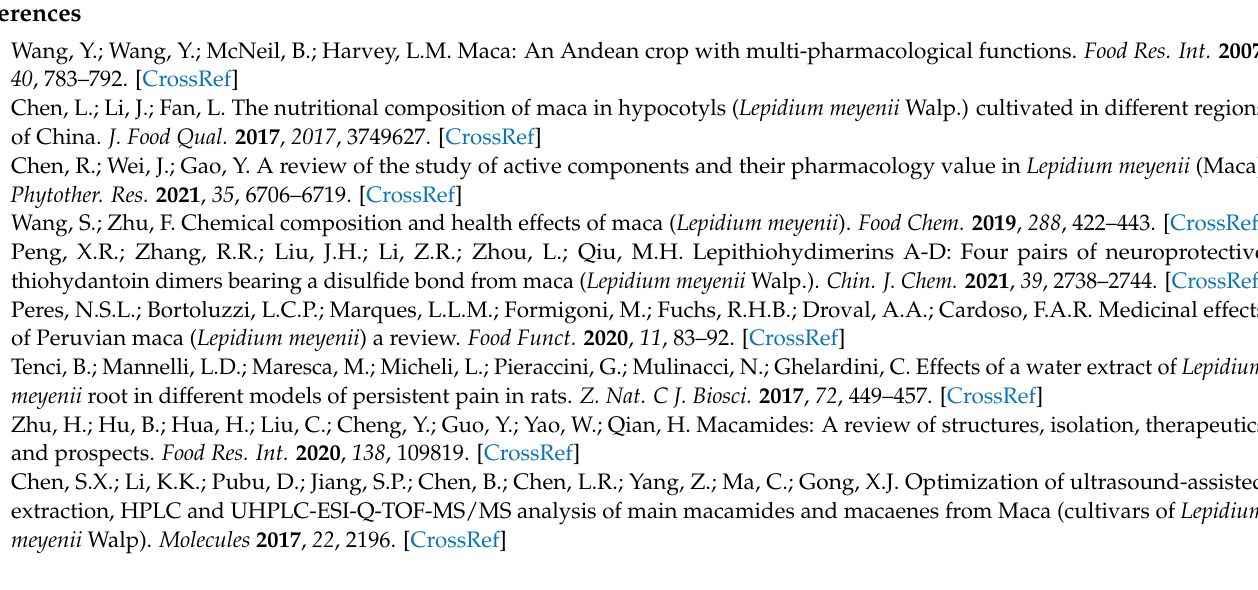
Figure S2: Effect of ultrasound power on the yields of the five target macamides ( 1 Extraction yields of C2, C4 and C5; 2 Extraction yields of C1 and C3); Figure S3: Effect of ratio of solution to solid on the yields of the five target macamides ( 1 Extraction yields of C2, C4 and C5; 2 Extraction yields of C1 and C3); Figure S4: Effect of extraction time on the yields of the five target macamides ( 1 Extraction yields of C2, C4 and C5; 2 Extraction yields of C1 and C3); Figure S5: Effect of extraction temperature on the yields of the five target macamides ( 1 Extraction yields of C2, C4 and C5; 2 Extraction yields of C1 and C3); Figure S6: Comparison of the extraction efficiency between DES and conventional organic solvents using UAE ( 1 Extraction yields of C2, C4 and C5; 2 Extraction yields of C1 and C3). Table S1: Linear regression, LODs, LOQs, precisions, stability, and repeatability of the four analytes using HPLC-DAD. Table S2: The optimal conditions of the DES-UAE for the five